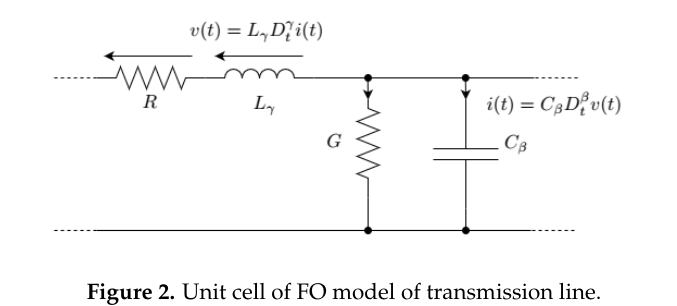
Figure 2. Unit cell of FO model of transmission